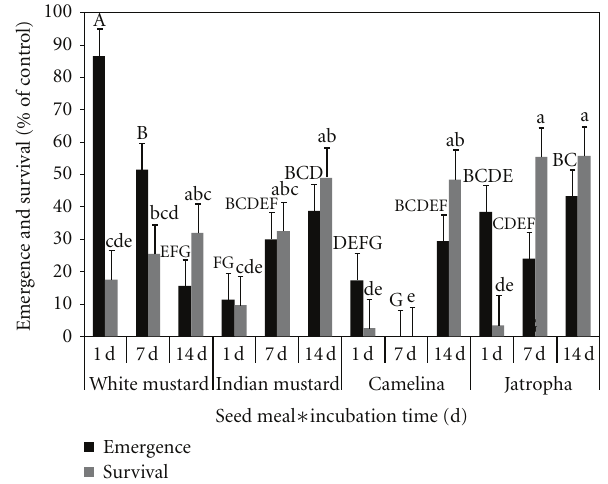
Figure 7: Interactive e ff ect of “seed meal source and incubation time” on cotton emergence and survival. Emergence (uppercase letters) or survival (lowercase letters) means followed by the same letter are not di ff erent at P < 0 . 05 by Fisher’s protected LSD. Data are means (four replications) ± SE.